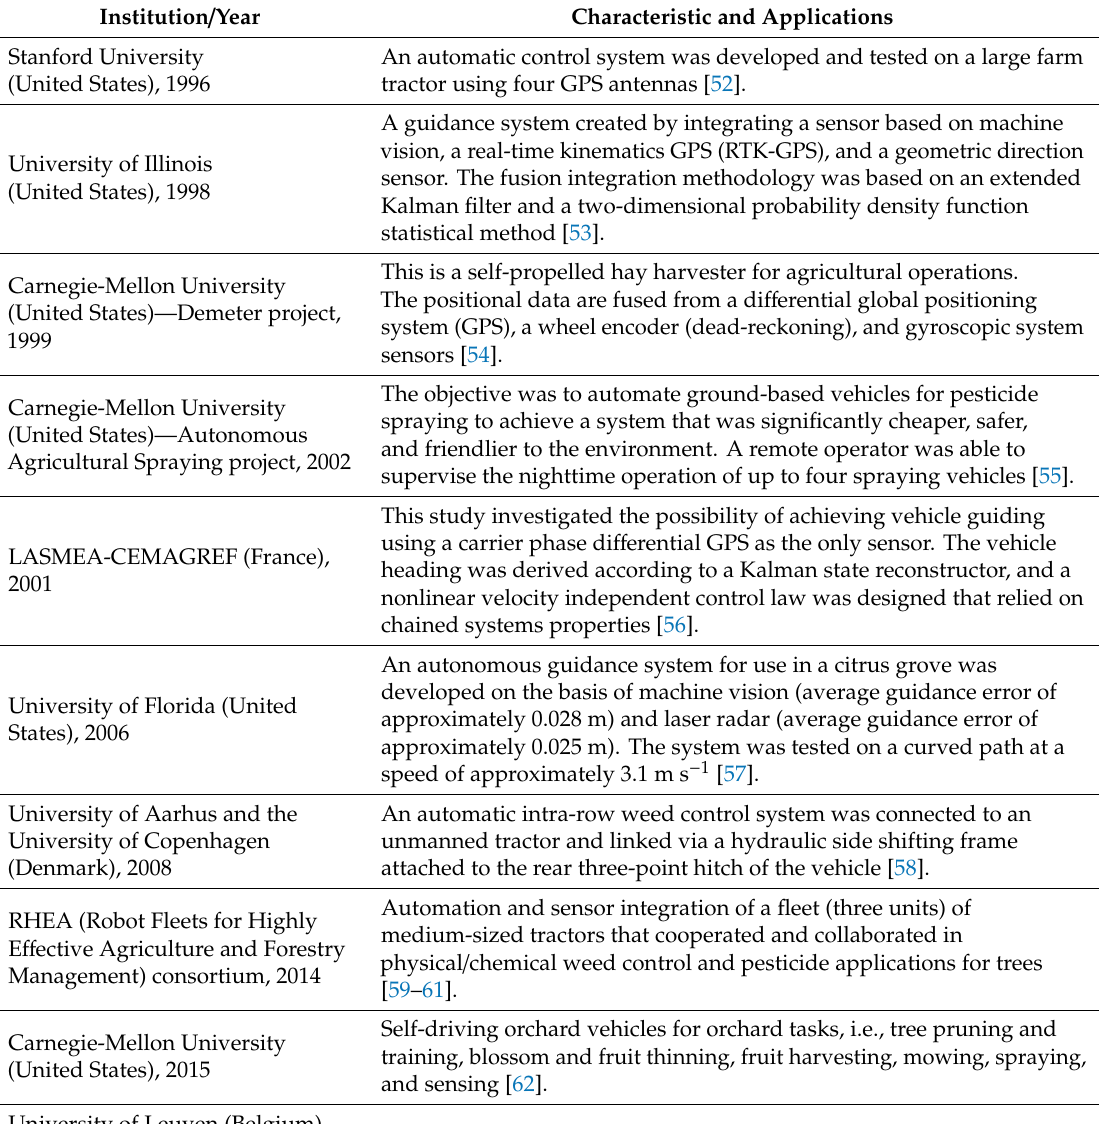
Table 2. Agriculture autonomous robots based on retrofitting conventional